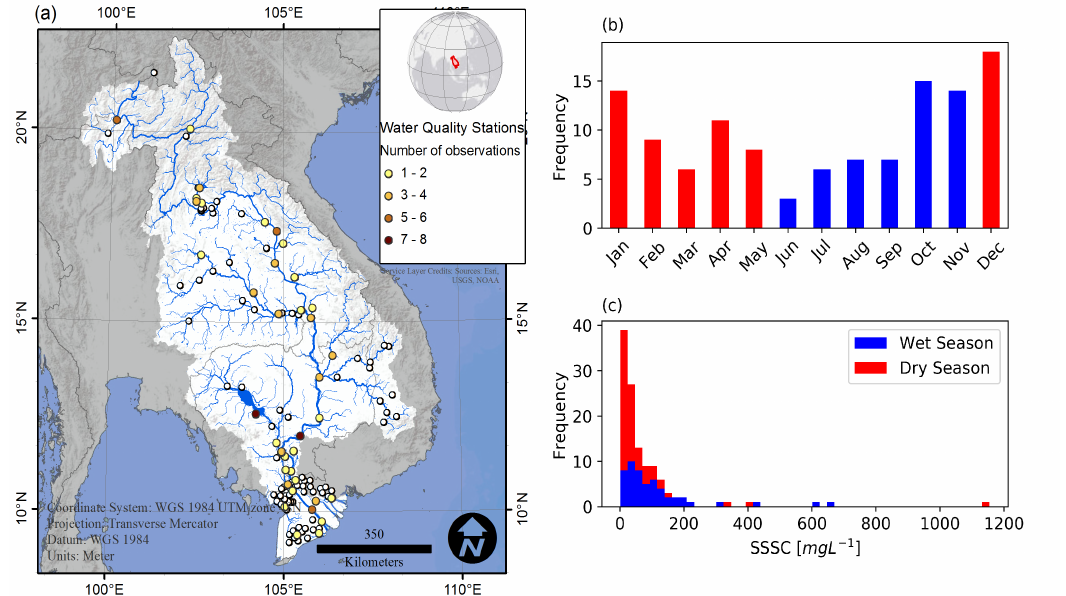
Figure 4. ( a ) Map highlighting the locations of water quality stations included in the calibration and validation dataset. Stations are coded by number of coincident Landsat 4, 5 and 7 observations from 1985 to 2011 for each station. Unused stations left out due to bank proximity or lack of coincidence Landsat data are shown in white; ( b ) Temporal distribution of Landsat observations coincident with in situ SSSC measurements in the calibration dataset ( n = 189); ( c ) Distribution of in situ SSSC values in the calibration